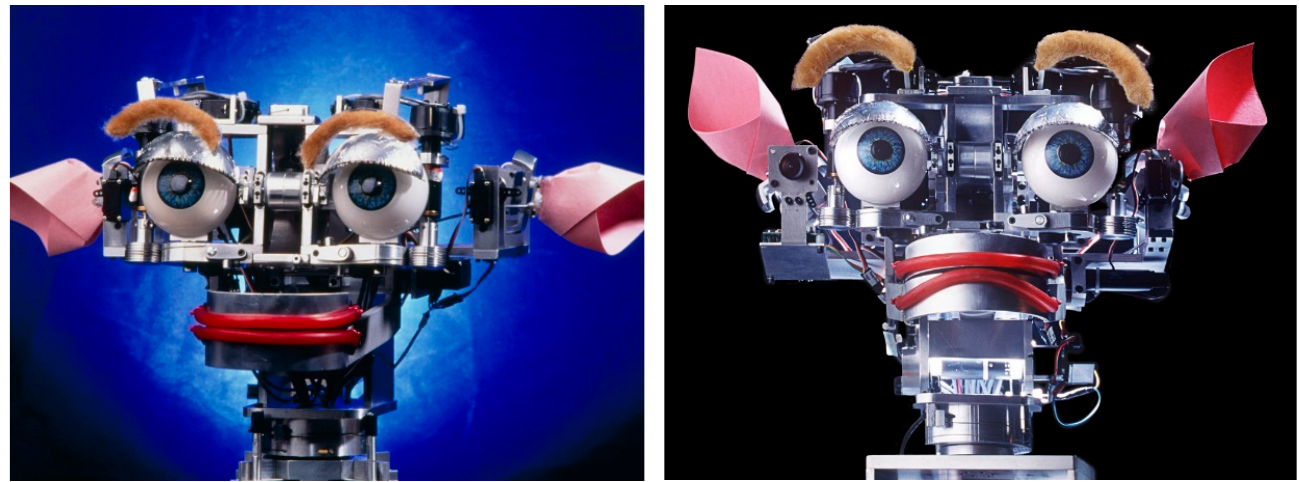
Figure 7. “Kismet” robot expression interactive vision system developed by MIT Artificial Intelli-